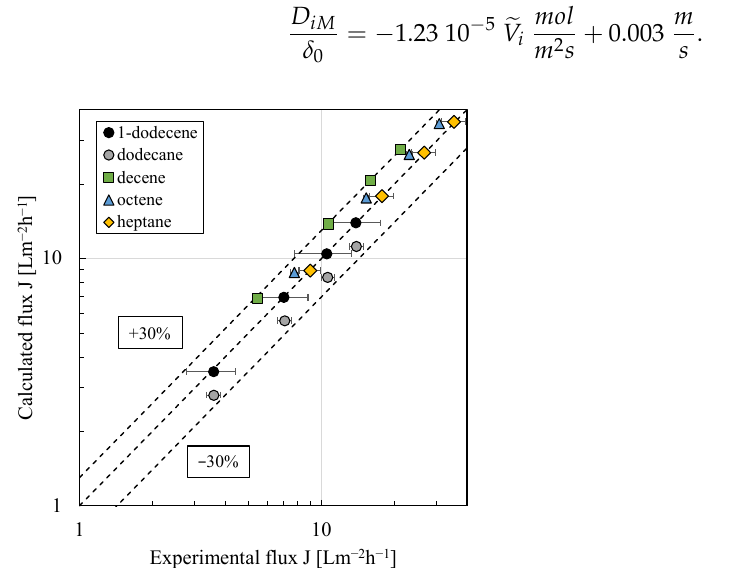
Figure 7. Calculated vs. experimental flux using the solution–diffusion model and a linear correlation between the ratio of (diffusion coefficient/dry active membrane layer thickness) and the molar volume of the organic solvent (Equations (3) and (5)). For the model fit, the experimental data of 1-dodecene and heptane were used. All pressure stepping experiments were conducted at least in duplicate and mean values are shown. Error bars represent the standard deviation. Where not visible, error bars are smaller than the symbol size.